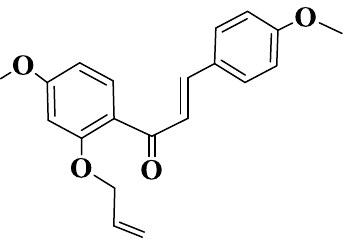
Figure 7. Structure of a semisynthetic chalcone (compound 138 ).